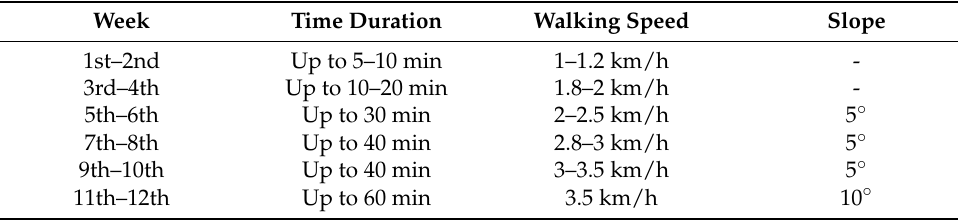
Table 3. Underwater treadmill locomotor